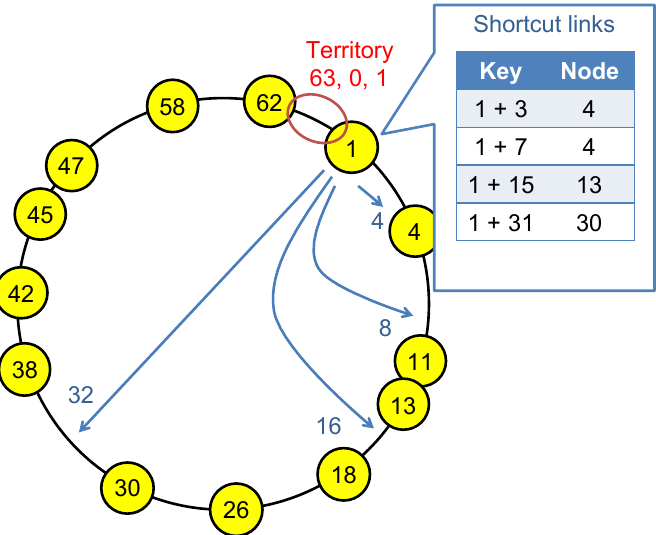
Figure 4. An example of the constructed shortcut links in our proposed